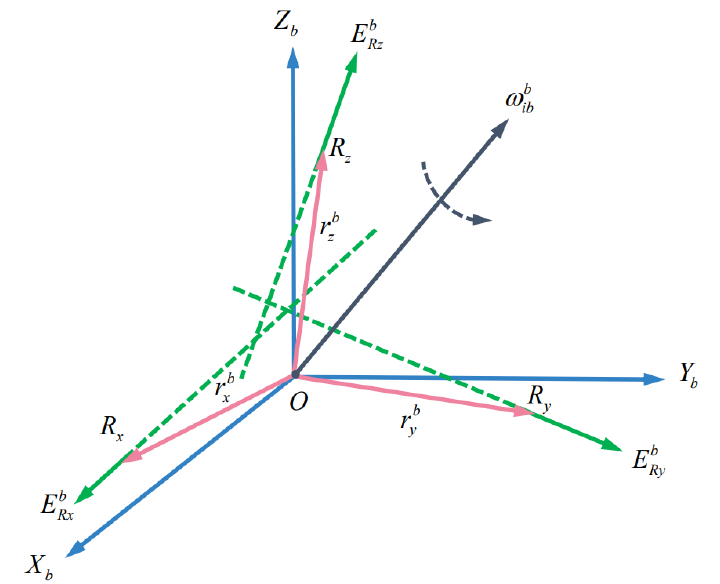
Figure 2. Schematic diagram of size